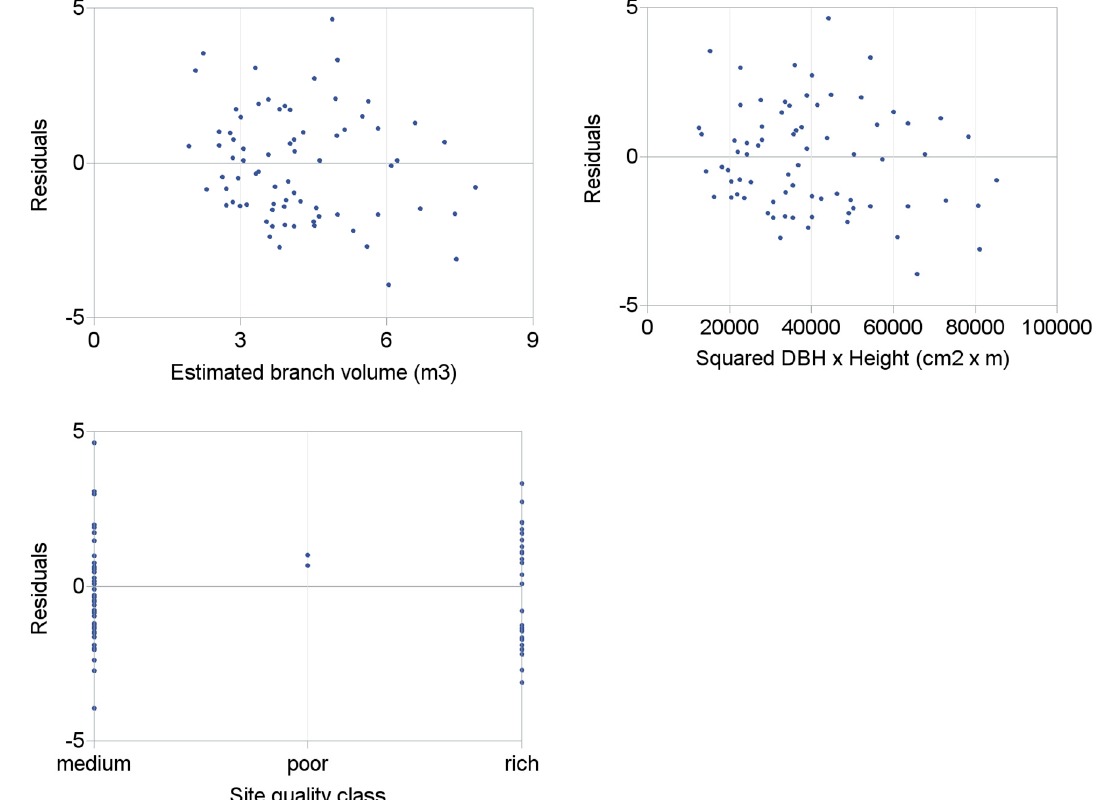
Figure 6. Residuals against predictor variables and estimated branch volume with a branch volume model (Equation 4).